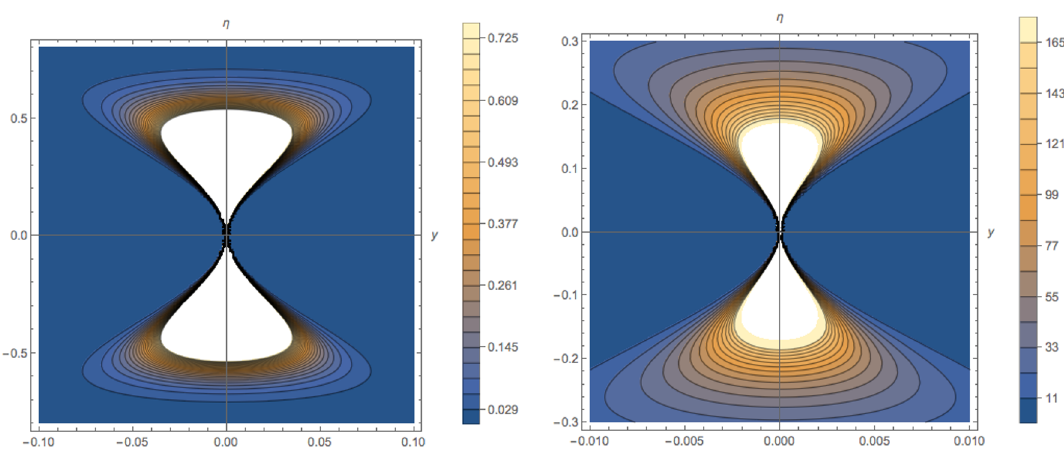
Figure 1 . Contour plots for the distribution G ( y, η ) , eq. (5.2), at two different scales, for σ p = σ q = 0 . 2